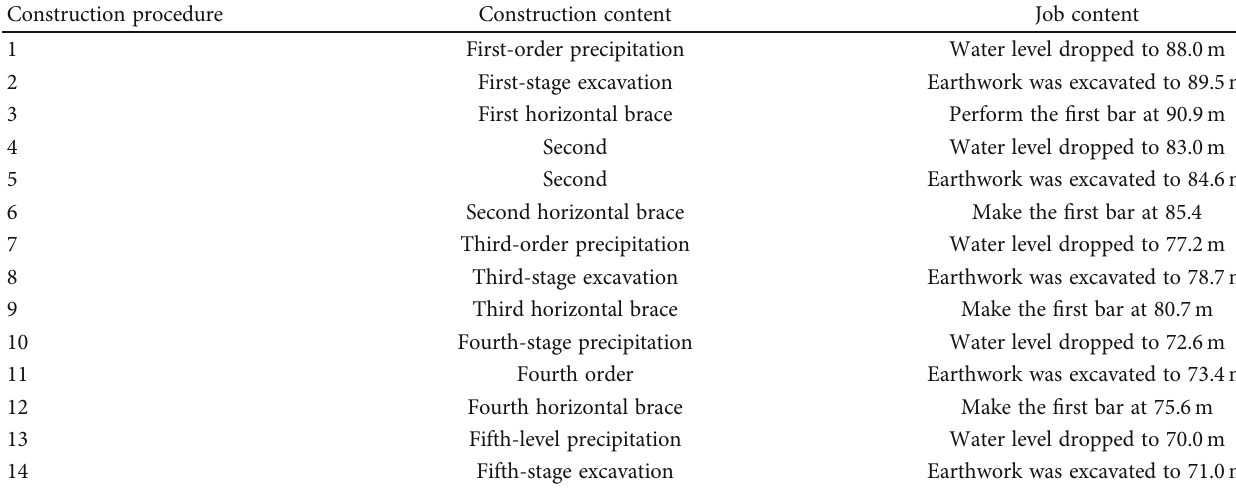
Table 1: Sequence of construction for the Yellow River Tunnel.